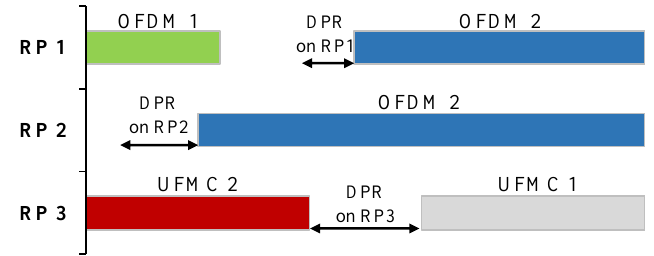
Figure 8. Example of the make-before-break approach to mitigate DPR